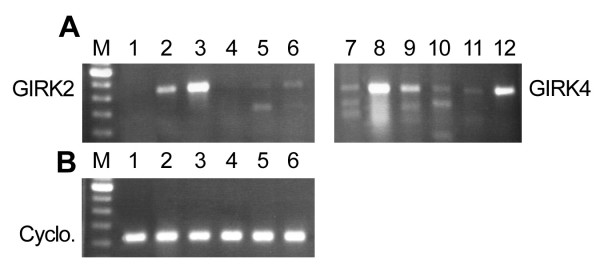
Agarose gel showing expression of mRNA for GIRK2 and GIRK4 in human breast cancer cell lines by RT-PCR. The GIRK2 and 4 primers amplified 438 & 401-bp fragments respectively, whereas the cyclophylin primers amplified a 216 bp fragment. Cyclophylin was used as a positive control for both GIRK2 and 4. For each cell line, a negative control reaction without M-MLV reverse transcriptase was performed and found to be negative. Lanes 1 & 7, ZR-75-1; Lanes 2 & 8, MCF-7; Lanes 3 & 9, MDA-MB-361; Lanes 4 & 10, MDA-MB-435S; Lanes 5 & 11, MDA-MB-453; Lanes 6 & 12, MDA-MB-468, Lane M, a 100 bp marker. PCR reactions resolved on this gel were in the plateau phase of PCR, therefore concentrations of PCR amplified cDNA samples cannot be compared.